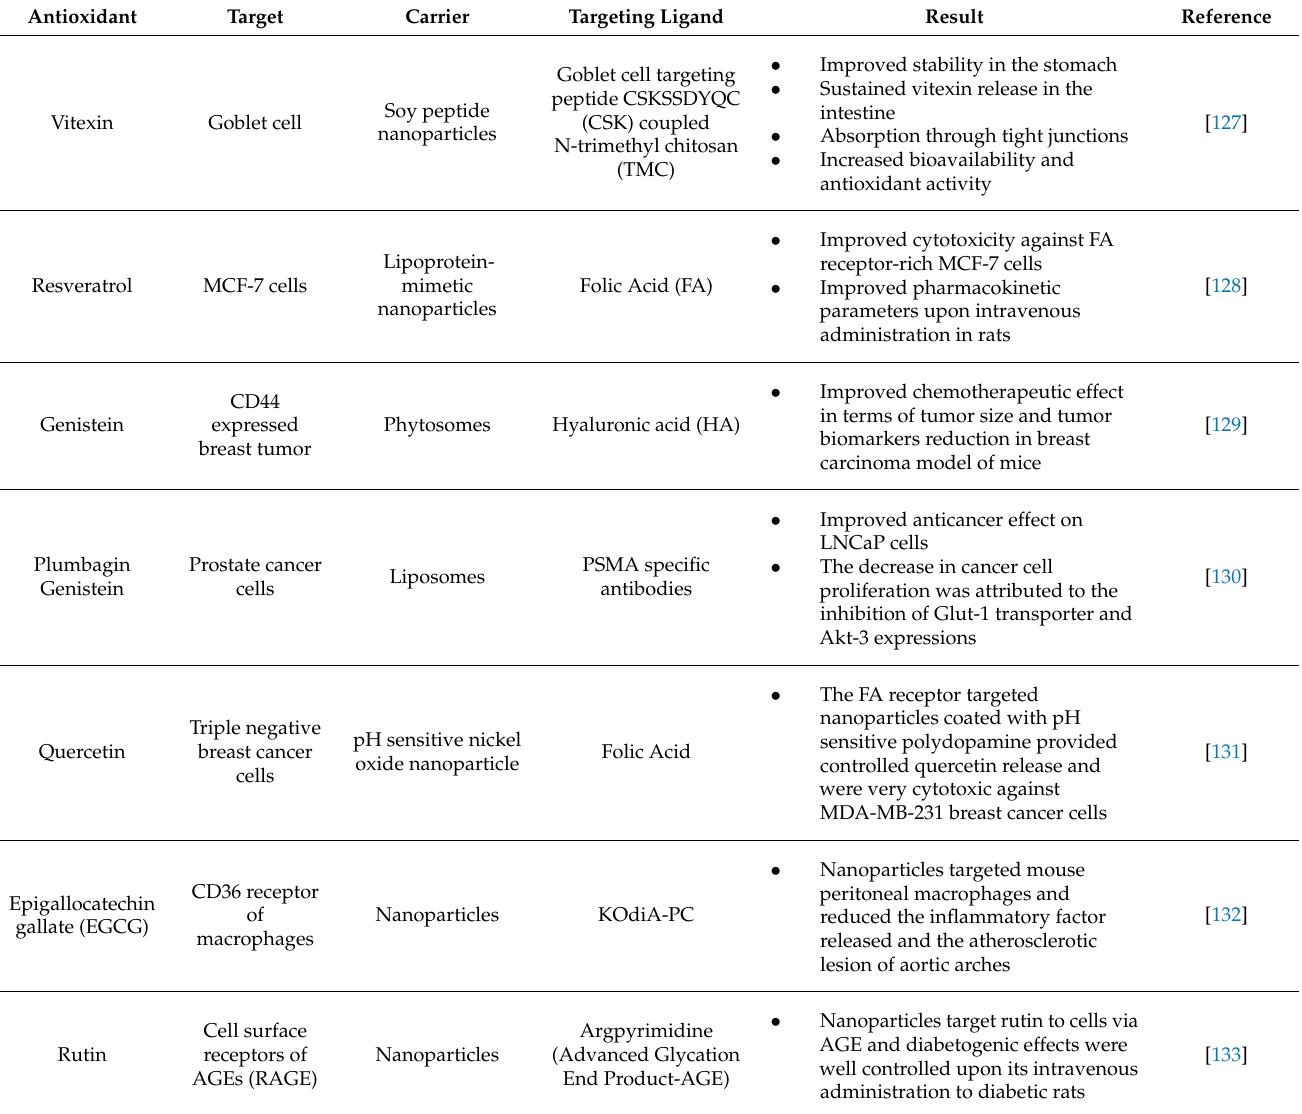
Table 7. Recent studies on NDDS based targeted delivery of